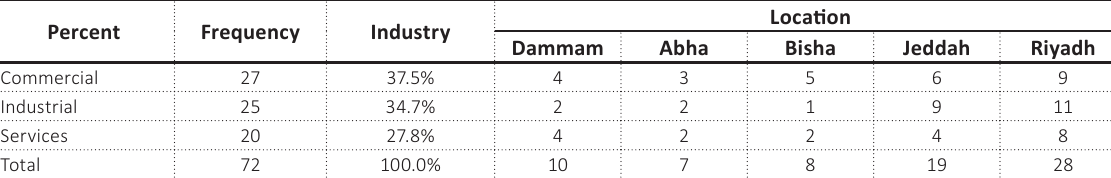
Table 2. Company’s frequency distribution based on its location